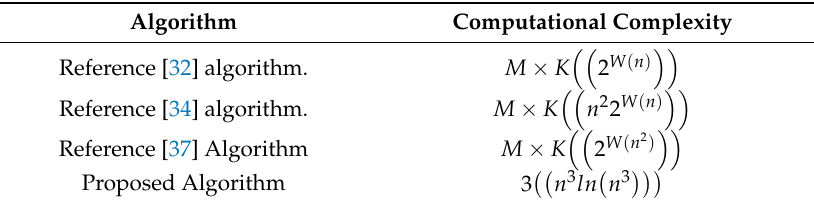
Table 2. Complexity